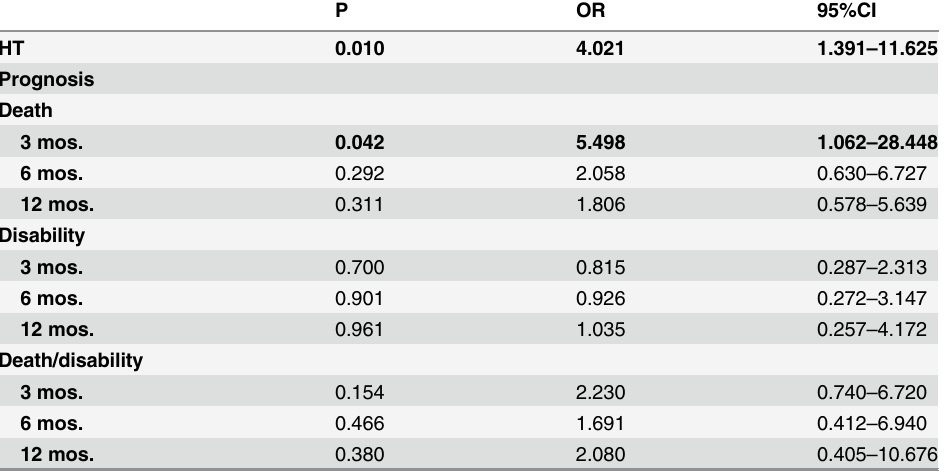
Table 4. Multivariate analysis of hemorrhagic transformation (HT) and prognosis in patients with ele- vated or normal hs-cTnT levels. * P